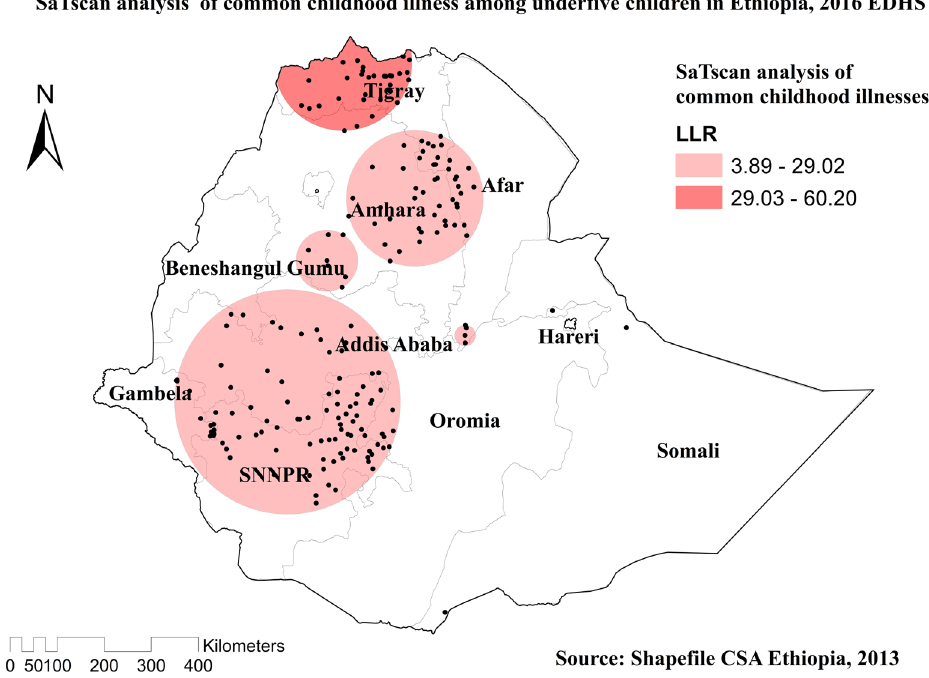
Figure 6. Spatial SaTScan analysis of common childhood illnesses among under-five children in Ethiopia, 2016